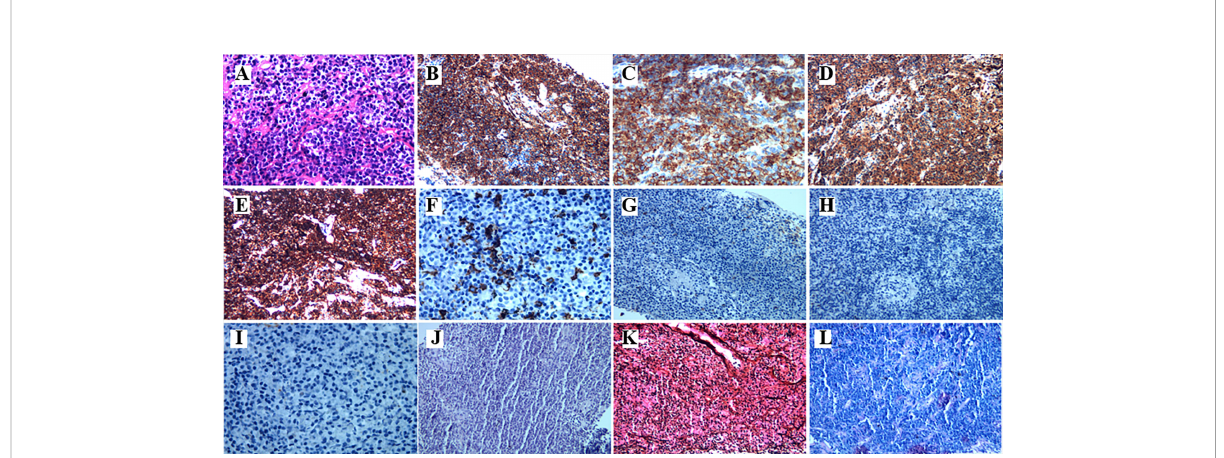
FIGURE 2 The histopathological characteristics of the tumor in the lung demonstrated by H&E and immunohistochemical staining. (A) Hematoxylin and eosin staining. The higher power view shows uniform small round blue cells with scant cytoplasm. (B – I) Immunohistochemical staining (400×magni fi cation) was positive for CD38, CD138, Kappa, and LCA(CD45), CD20, but negative for CD56, CK, INSM1, respectively. (J – L) Speci fi c stain of pathology of PAS, GMS, and acid fast stain,